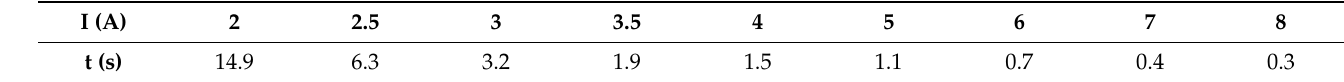
Figure 3. Temperature variation of NiTi SMA wire subjected to different currents.